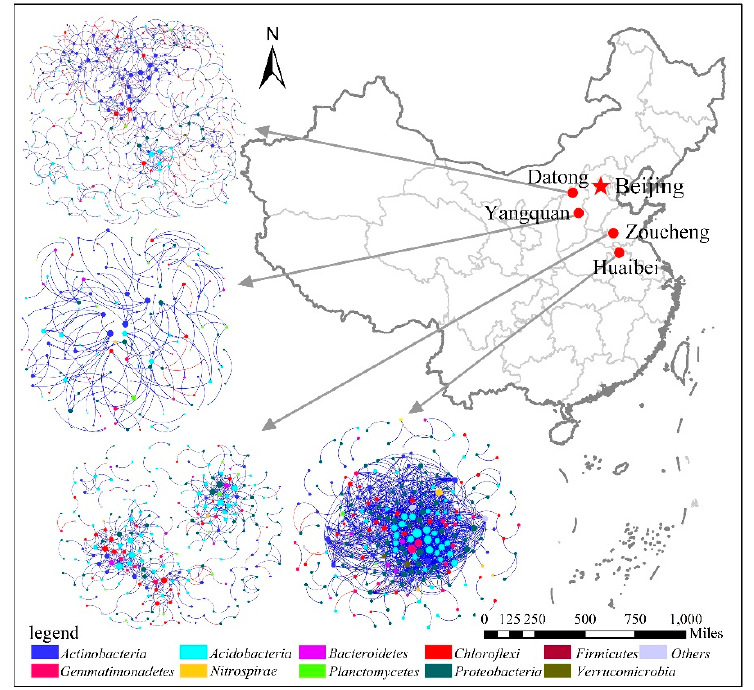
Figure 4. Overview of the networks in different mining areas, with node sizes being proportional to node degrees. A red link means a negative correlation and a blue link means a positive correlation.